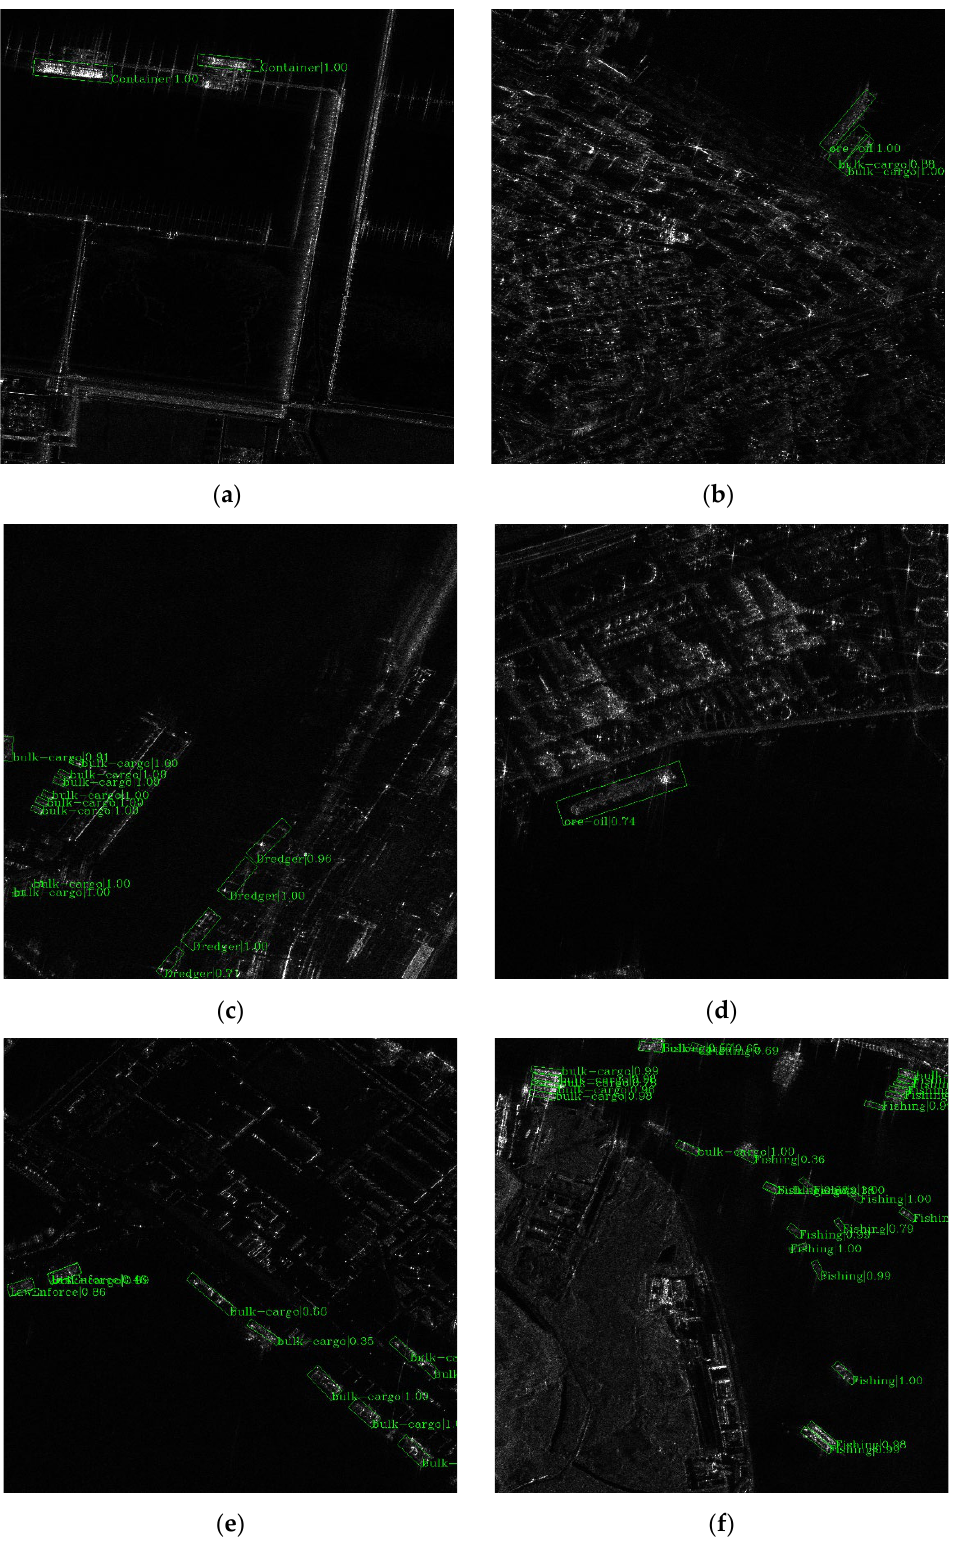
Figure 18. Some detection results of Oriented RCNN for the dataset. ( a ) Detection result including